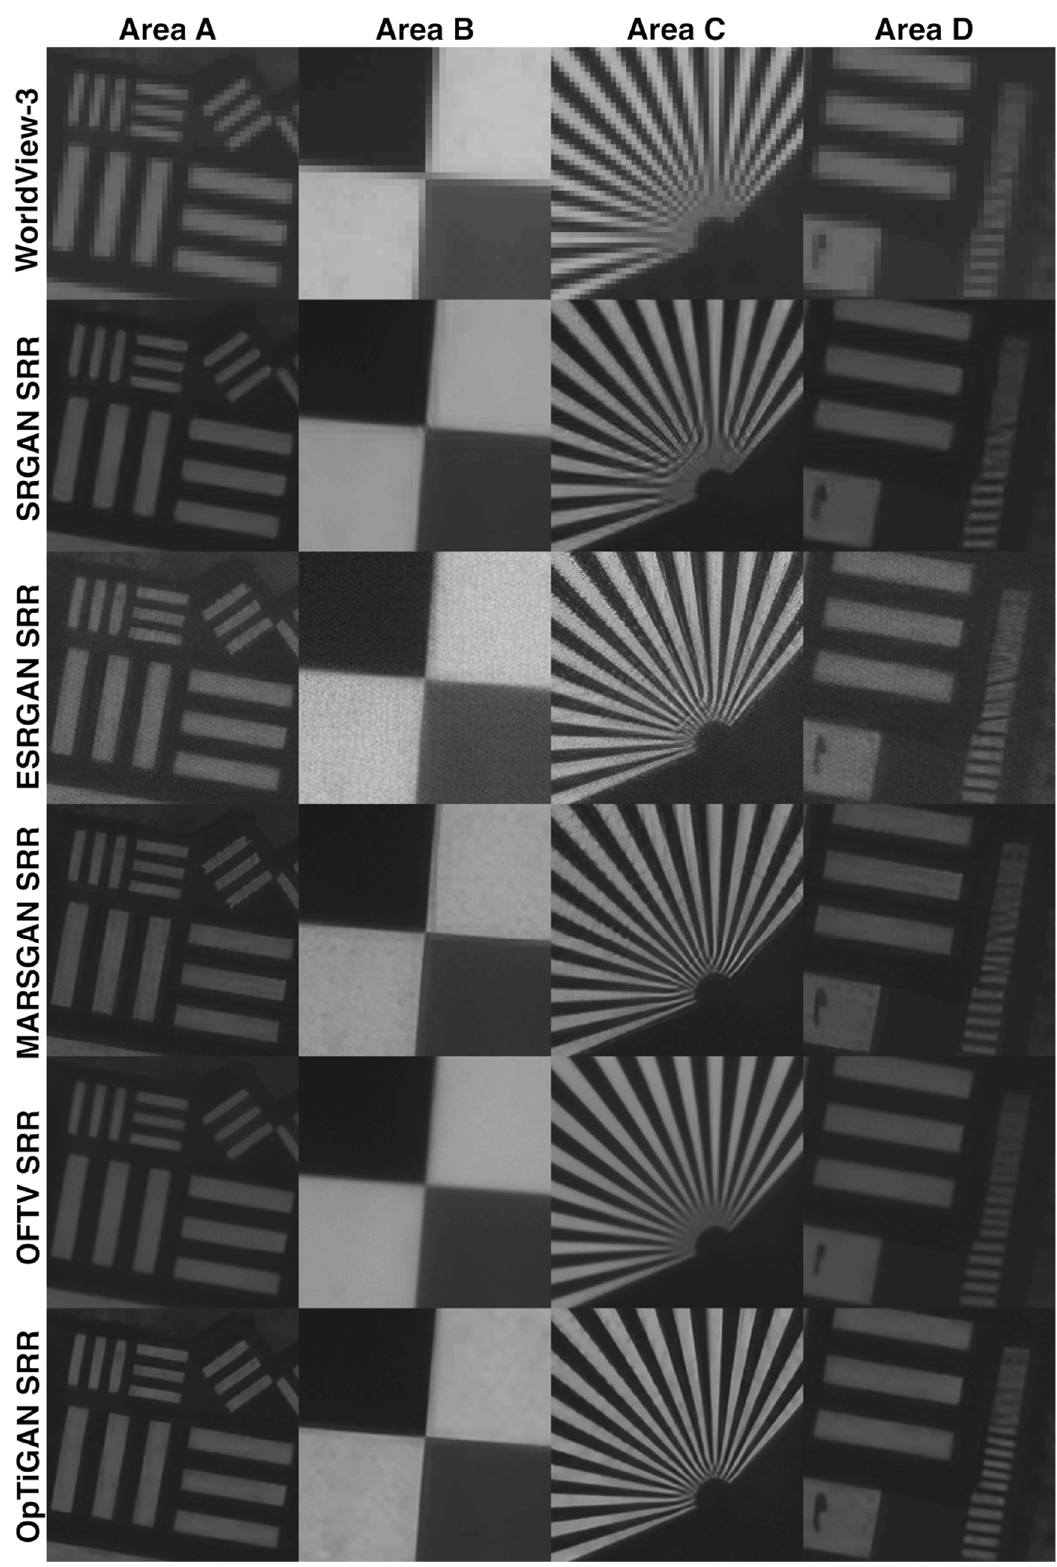
Figure 6. WorldView-3 ® SRR results, from SRGAN, ESRGAN, MARSGAN, OFTV and OpTiGAN, of four cropped areas on the bar-pattern targets, the knife-edge target and the fan-shaped target, at the Baotou Geocal site. Please refer to the Supplementary Materials for full-resolution images at larger size. WorldView-3 image courtesy of Maxar 2020. Data provided by the European Space Agency.